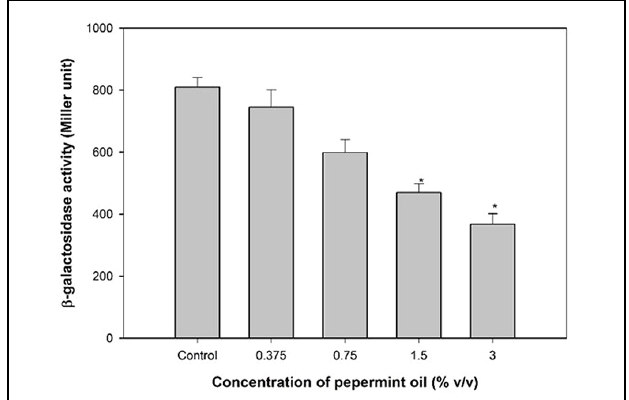
FIGURE 5 | Effect of PMO on las systems. β -Galactosidase activity was measured in the Escherichia coli MG4/pKDT17 with and without sub-MICs of PMO. All of the data are presented as mean ± SD. Significance at ∗ p ≤